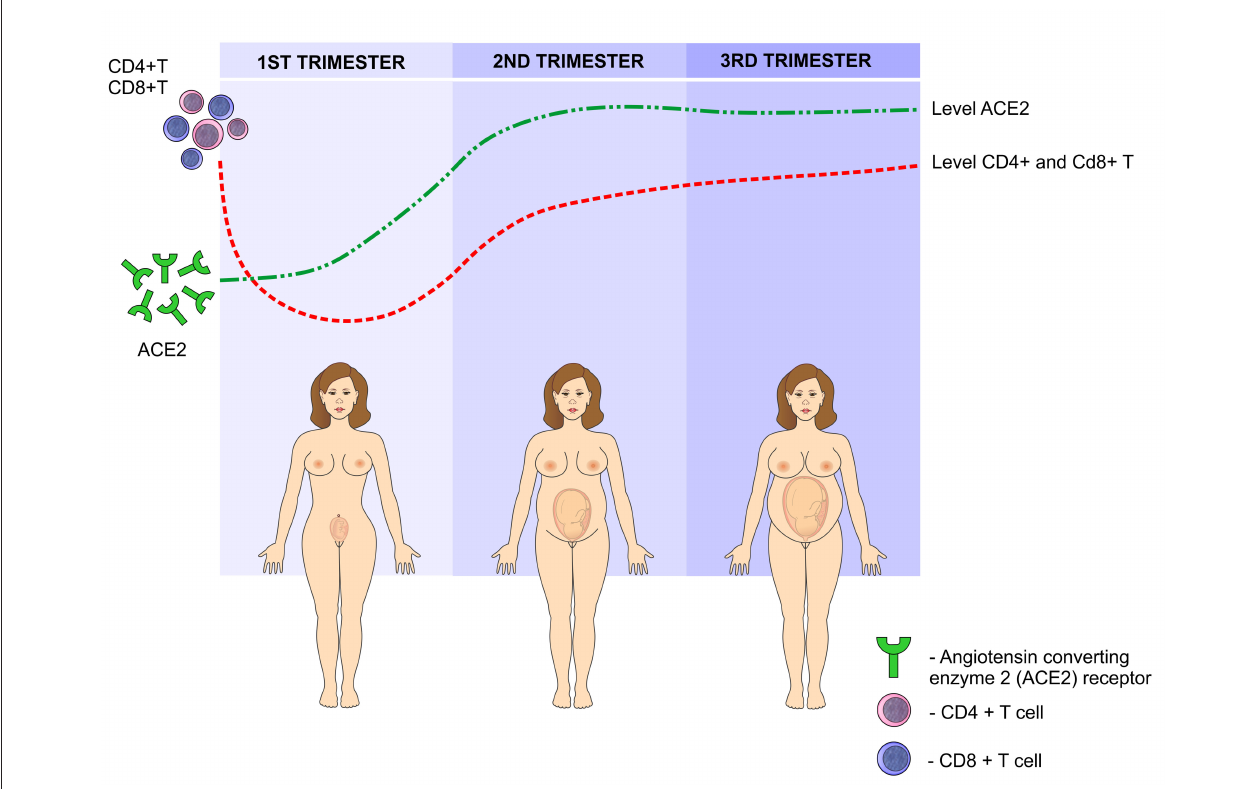
FIGURE 7 | SARS-CoV-2 infection during pregnancy: In the first trimester of pregnancy, the levels of angiotensin-converting enzyme 2 (ACE2) increase, peaking in the second trimester and reaching a plateau in the third semester. This enzyme facilitates the binding of the virus to the cells. On the other hand, due to the presence of paternal antigens foreign to the mother’s body, immunity is modulated by reducing the levels of CD4 + T and CD8 + T lymphocytes in the first trimester, gradually increasing in the second and third